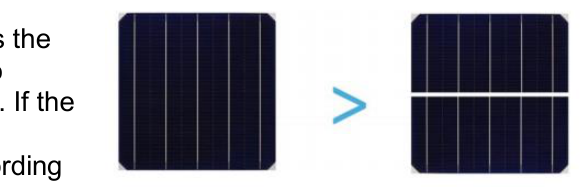
Figure 2. Half-cell technology